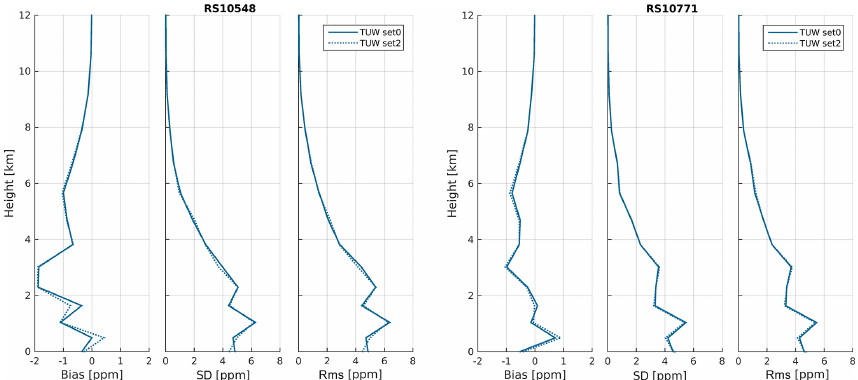
Figure 10. Statistics of the differences in wet refractivity between radiosonde data and various tomography solutions. Differences between set0 and set2 are related to the strategy for compensation for the outer tropospheric delay.